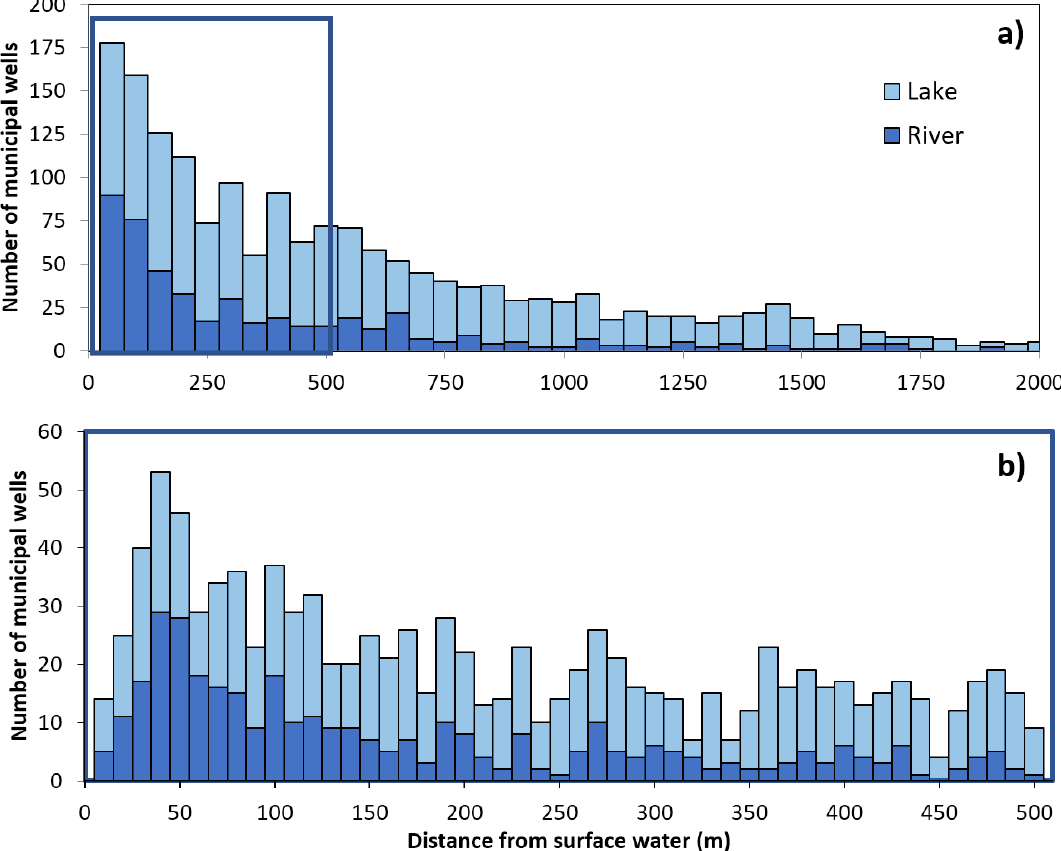
Figure 2. The distance of municipal wells from water surfaces for ( a ) 0 to 2000 m and ( b ) 0 to 500 m.